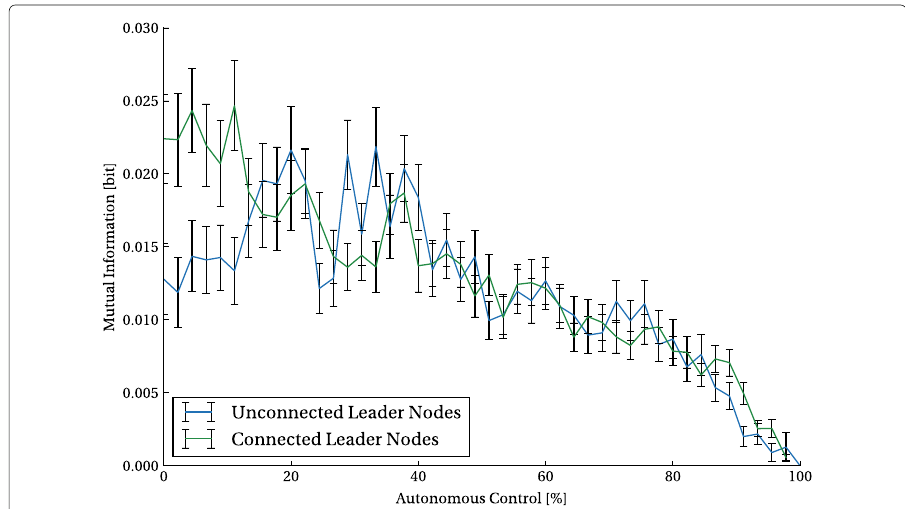
Fig. 4 Mutual information from leader to ring nodes based on solution regimes as a function of the degree of autonomous control